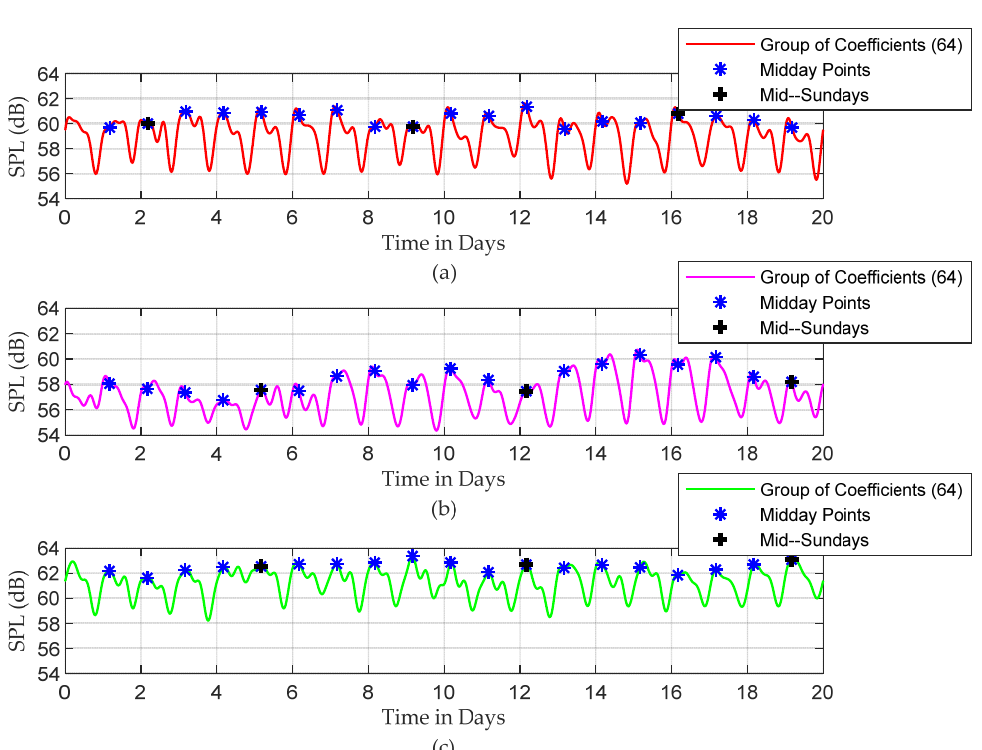
Figure 8. Periodicity of reconstructed SPLs time series over 20 days by employing IFFT to the first 64 points: ( a ) ICU1, ( b ) ICU2, and ( c ) ICU3.